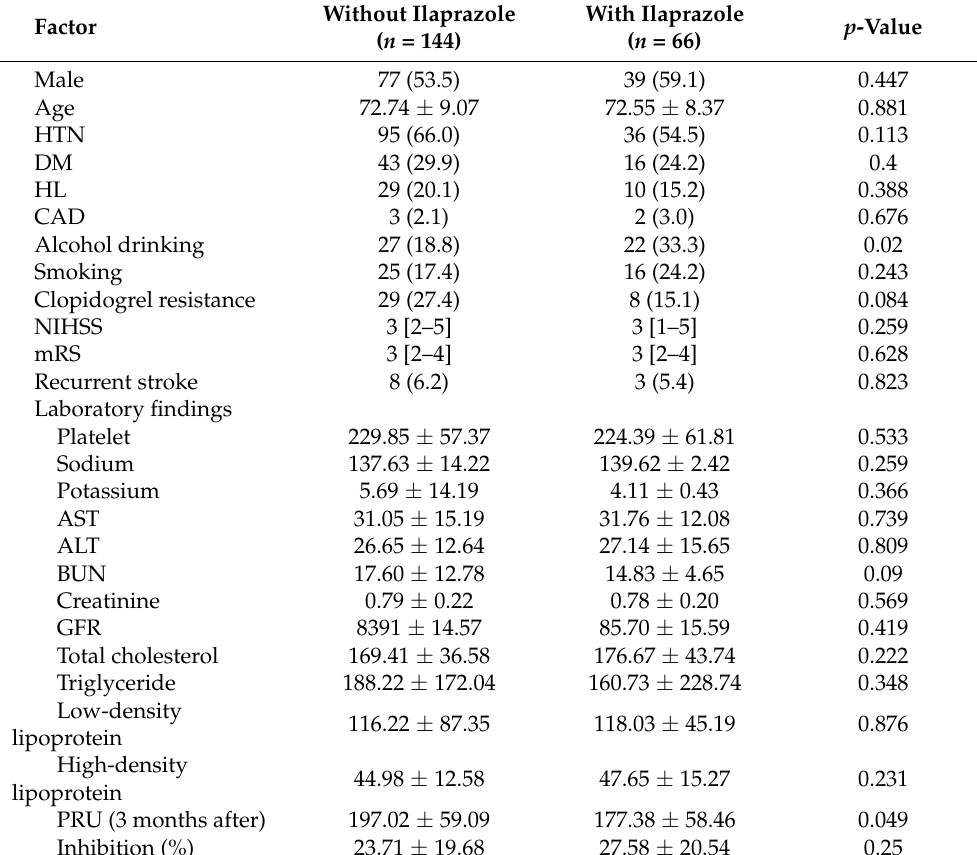
Table 3. Comparison of baseline characteristics between patients taking versus not taking ilaprazole. Factor